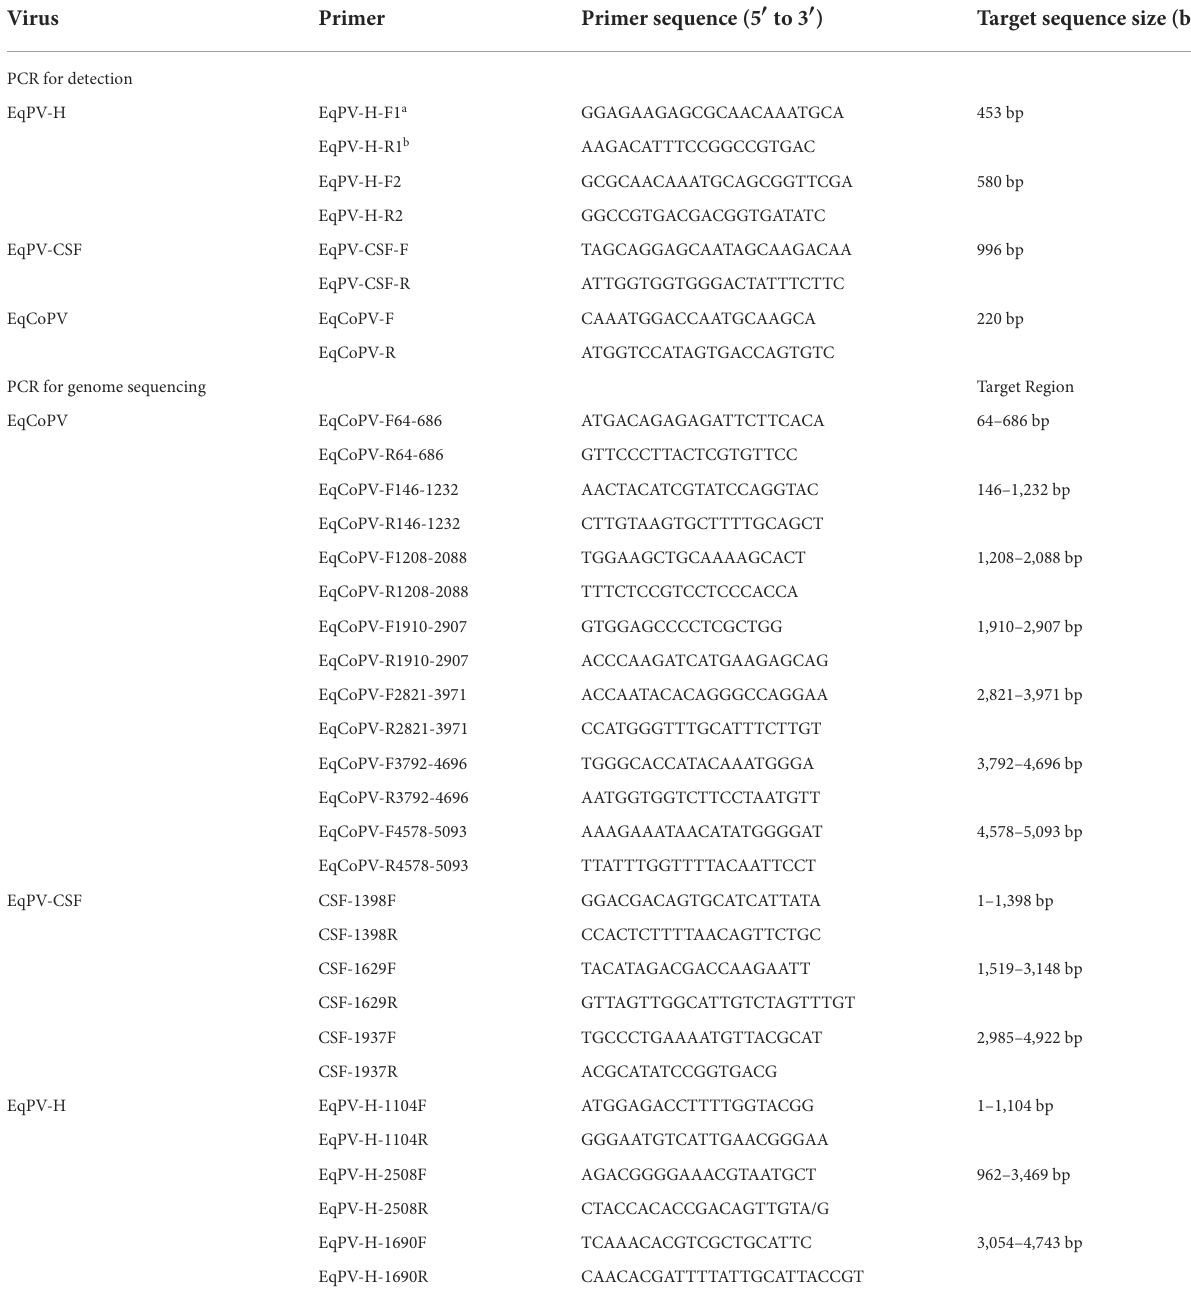
TABLE 1 Primers used for virus detection and genome sequencing. Virus Primer Primer sequence (5 ′ to 3 ′ ) Target sequence size (bp) PCR for